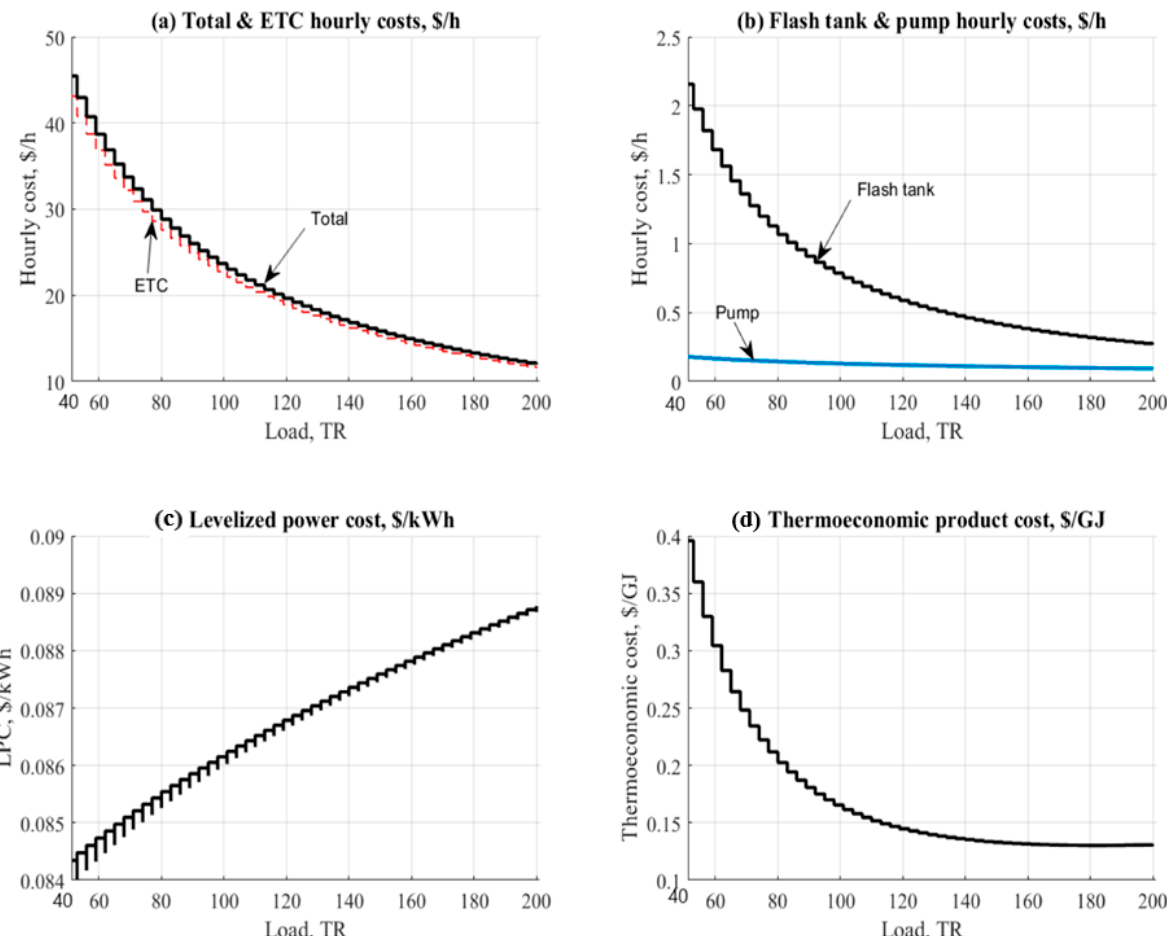
Figure 8. Data results for ETC/NH3 ‐ H2Ocycle vs. cooling load. ( a ) ETC total hourly cost. ( b ) Flash tank and pump hourly cost. ( c ) Levelized power cost. ( d ) Thermo ‐ economic product.